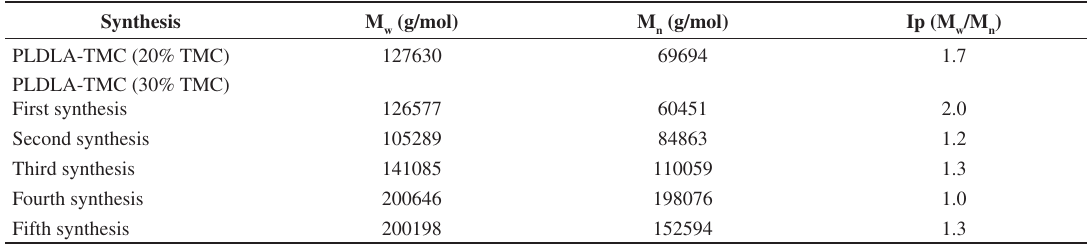
Table 4. Gel permeation chromatography analysis of PLDLA-TMC synthesized by ring-opening polymerization catalyzed with Sn(Oct) Synthesis